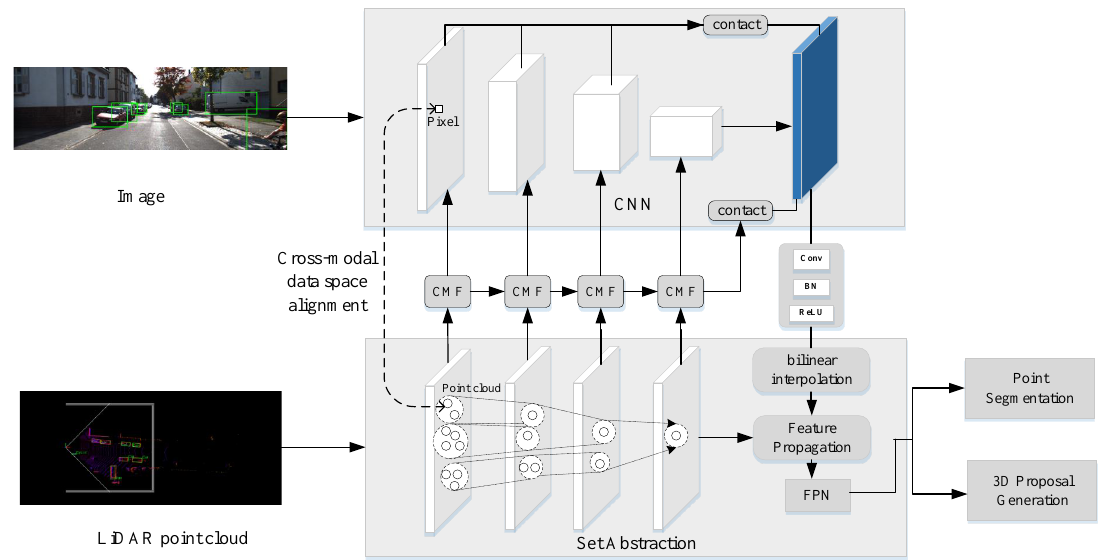
Figure 1. Overview of our CCFNet. ResNet50 and four Set Ablation modules of PointNet are used as feature extractors of RGB image and LIDAR respectively. Cascaded multi-scale fusion module (CMF) modules in four stages have little difference with each